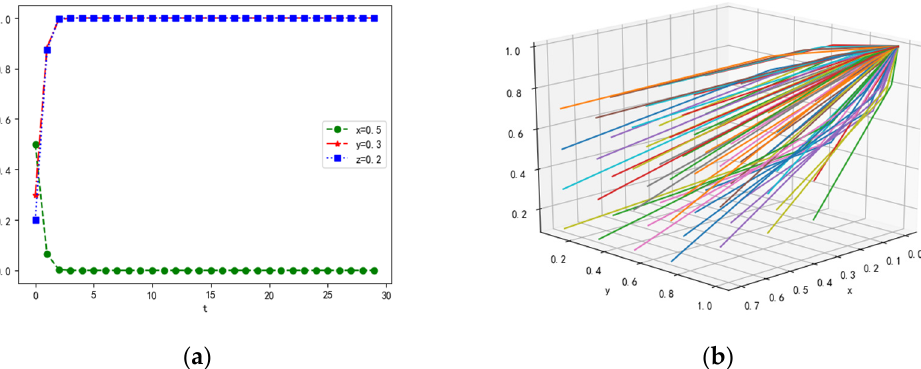
Figure 8. Evolutionary results of 𝑝 (cid:2875) (0,1,1) shown a corresponding under a constraint condition, ( a ) represents the convergence of probability with time, and ( b ) shows the results of dynamic simulation in three dimensions.